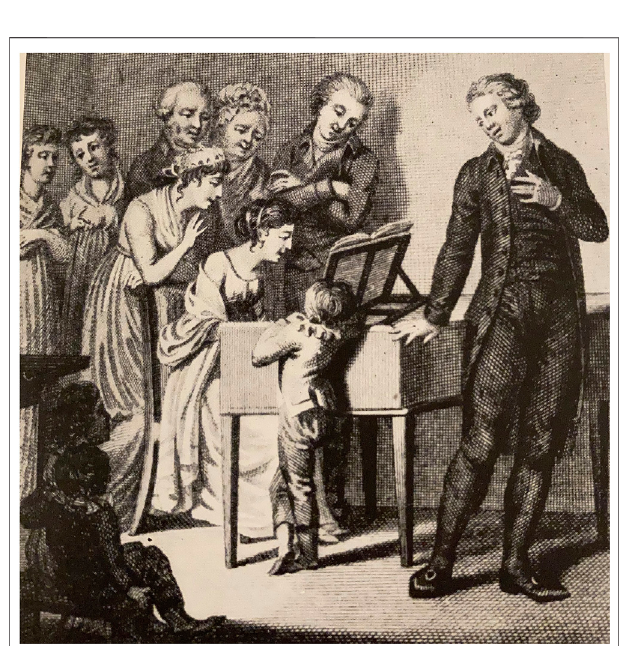
FIGURE 4 | Meno Haas, after Heinrich Anton Dähling, Familienkonzert (1800). Meno Haas, after Heinrich Anton Dähling, Die Klaviervirtuosin (Berlin, 1800). Courtesy of Kunstsammlungen der Veste Coburg, Inv.-Nr. V,112,111.